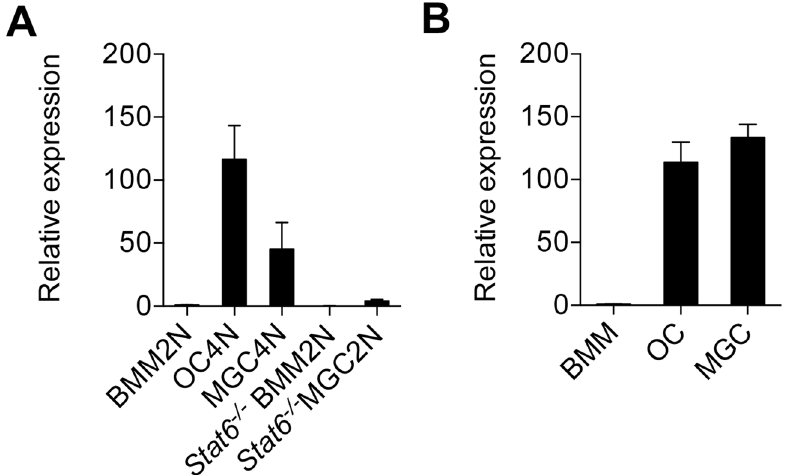
Figure 1. Expression of P2rx5 is associated with cellular multinucleation. ( A ) Expression of P2rx5 in pre- commitment mono-nuclear cells and multinucleation-committed bi-nucleated cells. Relative expression of P2rx5 compared to bi-nuclear BMMs (BMM2N). Multinucleation-committed bi-nucleated cells were sorted from RANKL + M-CSF-induced OCs or from IL-3 + IL-4-induced MGCs, and pre-commitment mono-nuclear cells were sorted from M-CSF-cultured BMMs, or from IL-3 + IL-4-induced STAT6 − / − MGCs. Total RNAs were isolated, and all transcripts were sequenced by RNA sequencing. Results of the expression of P2rx5 are shown as mean ± SD of three independent experiments. ( B ) qPCR validation of P2rx5 expression in BMMs, OCs and MGCs. Relative expression of P2rx5 compared to BMMs is shown. Data were normalized to 18s rRNA and are shown as mean ±